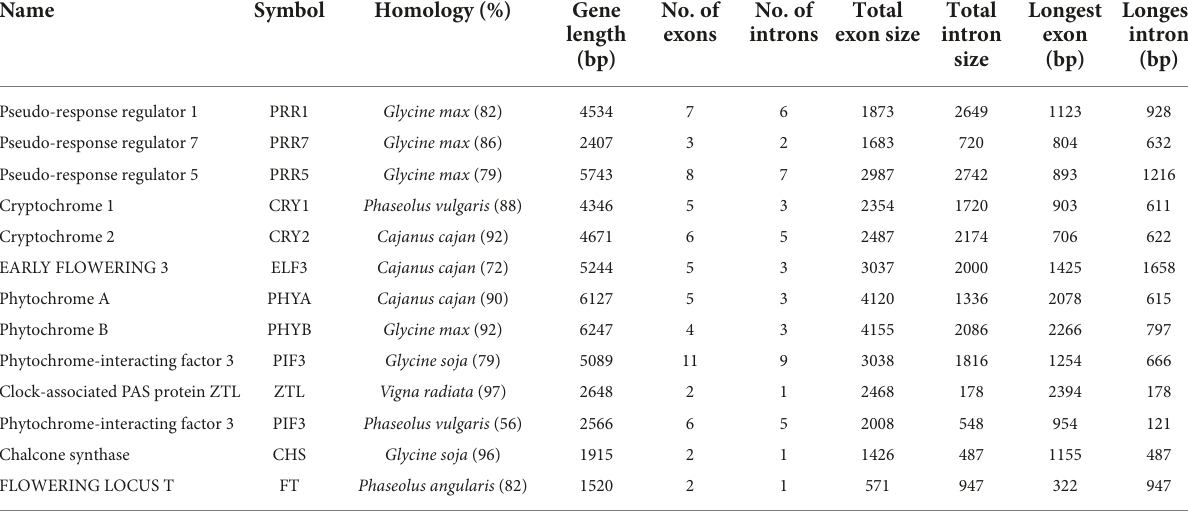
TABLE 6 Gene characteristics of key enzymes involved in circadian rhythms and flowering regulation in